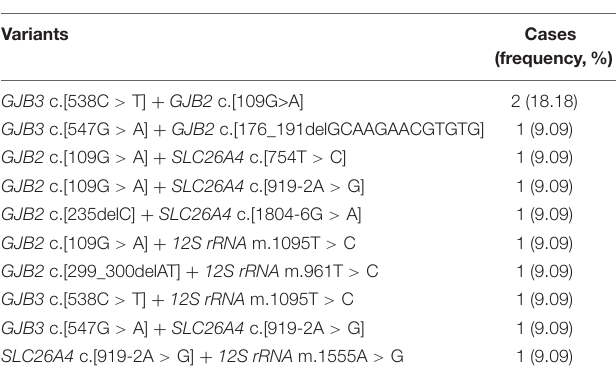
TABLE 6 | Multilocus variation.